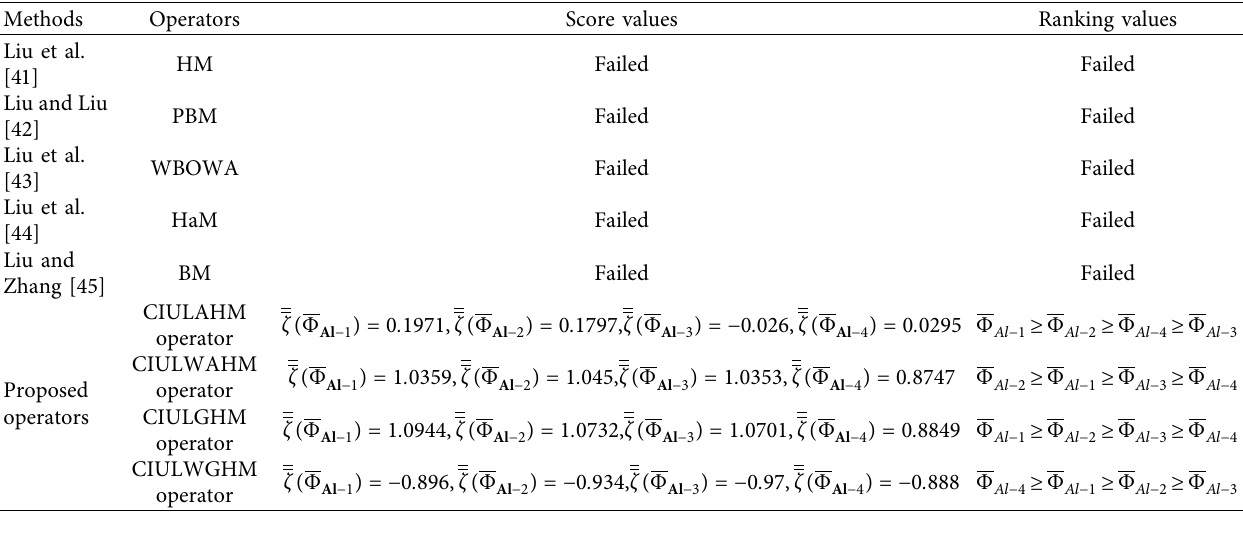
Table 10: Comparative analysis of the proposed and existing operators for Example 1.